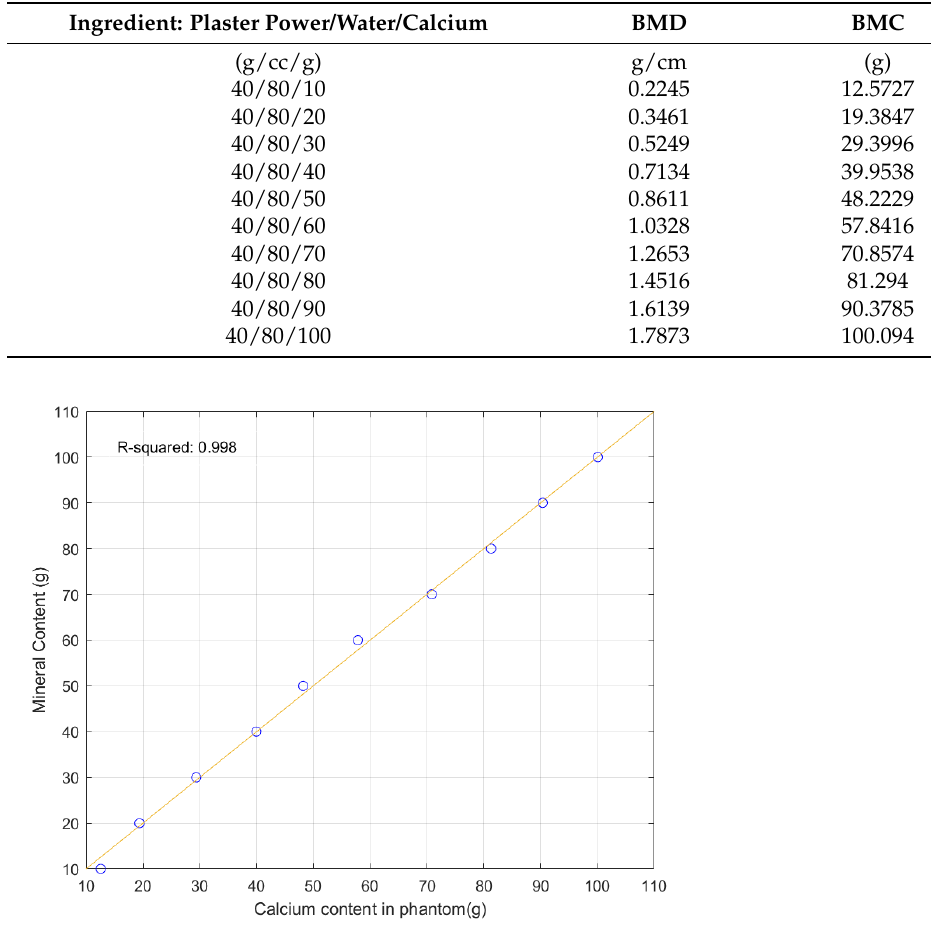
Figure 11. High ( a ) and low ( b ) energy detector image of calcium phantom. Table 3. Mineral density and concentration of calcium phantom.